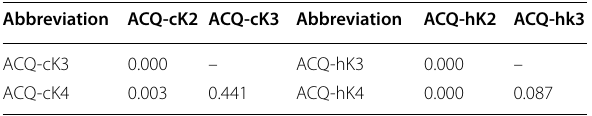
Table 7 Adjusted p value between stakes treated with ACQ-1 in different performance